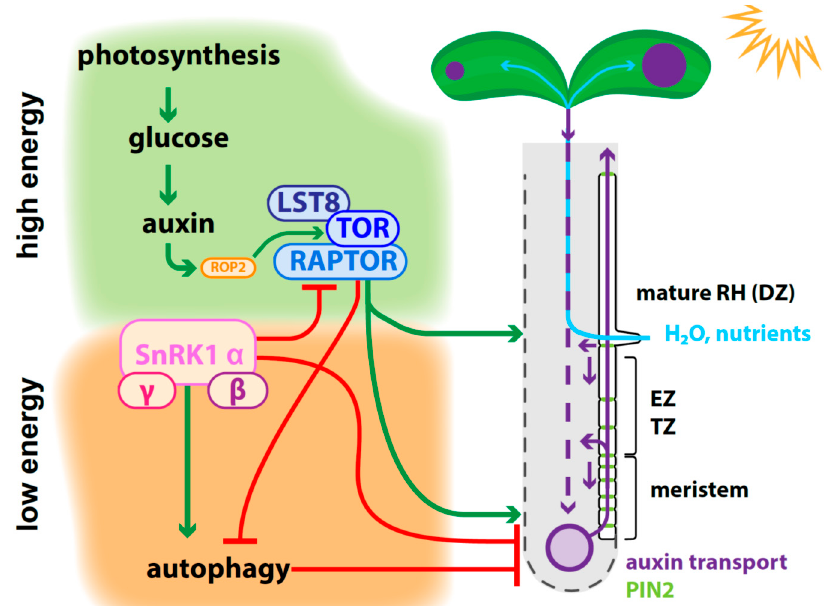
Figure 1. Energy status and resource uptake are orchestrated by an interplay of TARGET OF RAPAMYCIN (TOR) and SNF1-RELATED KINASE 1 (SnRK1) complexes, which antagonistically modulate root and root hair growth. High energy status results from sugar synthesis derived from photosynthesis in the leaves, which is followed by elevated auxin biosynthesis. Auxin signaling enhances RHO-RELATED PROTEIN FROM PLANTS 2 (ROP2) activity, and ROP2 binds TOR and promotes its phosphorylation. This results in the activation of the TOR complex, which further consists of the substrate-presenting subunit REGULATORY-ASSOCIATED PROTEIN OF TOR (RAPTOR) and the complex stabilizer LETHAL WITH SEC THIRTEEN 8 (LST8), described in Section 2.1. TOR signaling positively correlates with root meristem activity and therefore with root length. TOR stabilizes the auxin efflux carrier PIN2 by phosphorylation at the plasma membrane, and thereby modulates shootward auxin transport. Auxin levels in the meristem enhance the cell proliferation rate and are involved in root hair cell priming (described in Section 3.1.). Furthermore, efficient auxin delivery and signaling trigger root hair elongation, which is responsible for root surface enlargement, allowing enhanced uptake of water and nutrients to ensure plant